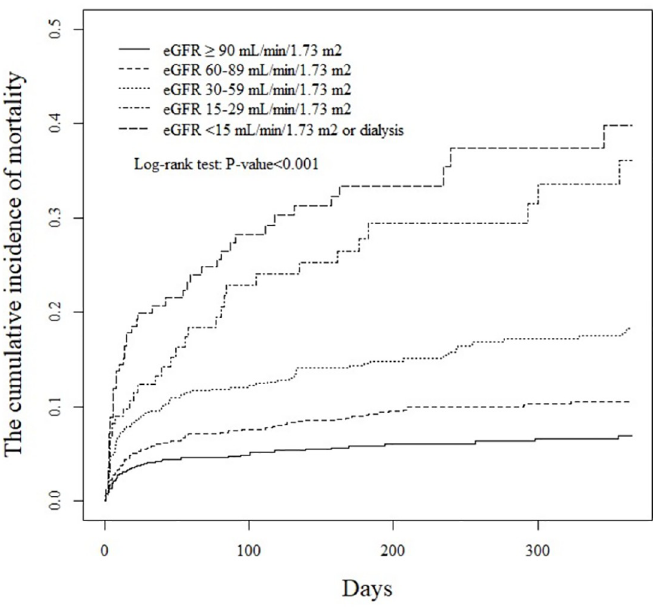
Fig 2. The cumulative incidence of mortalities after intracerebral hemorrhagic by eGFR levels on admission.